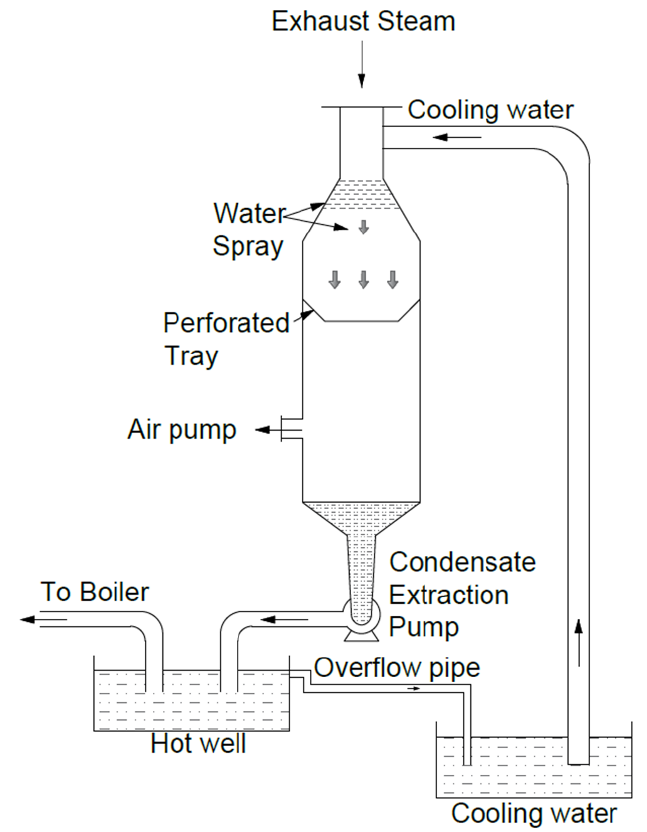
Figure 2. Parallel flow type condenser.